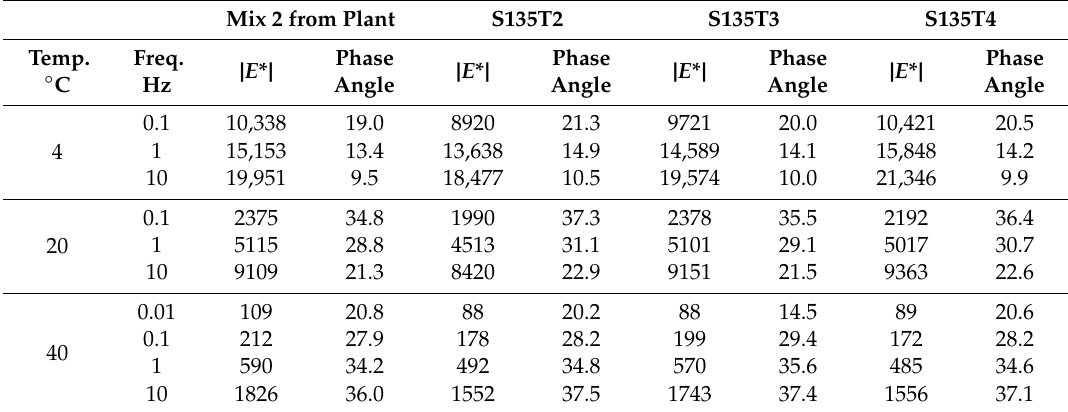
Table 4. Comparison of dynamic modulus results on mixture 2.